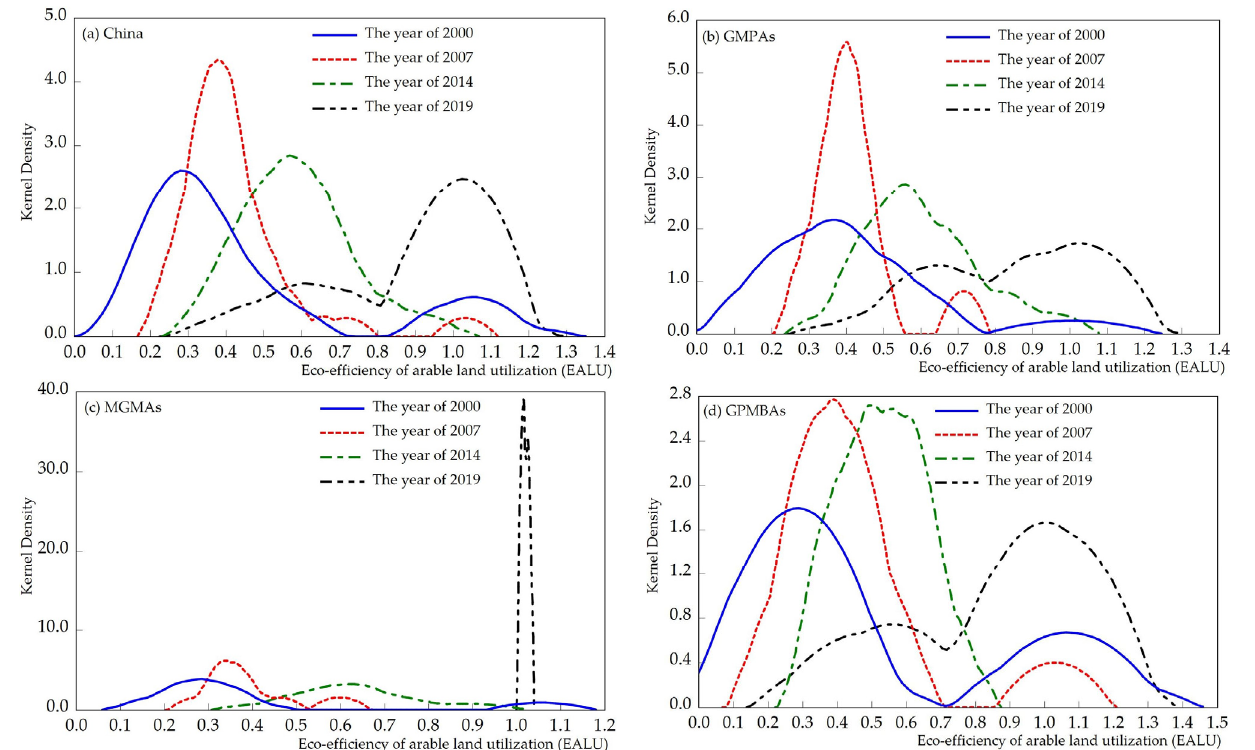
Figure 4. The kernel density distribution of EALU: (a) China; (b) main grain producing areas (MGPAs); (c) main grain marketing areas (MGMAs); (d) grain producing and marketing balance areas (GPMBAs).